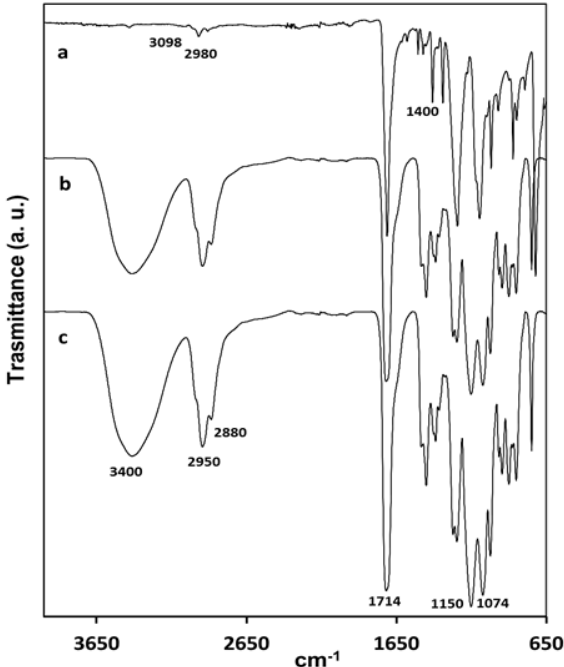
Figure 1. FTIR-ATR spectra of ( a ) unmodified PET, ( b ) UV PET 95:5:0.5 67% hydrogel, and ( c ) γ 60 PET 90:10:50 400% hydrogel.